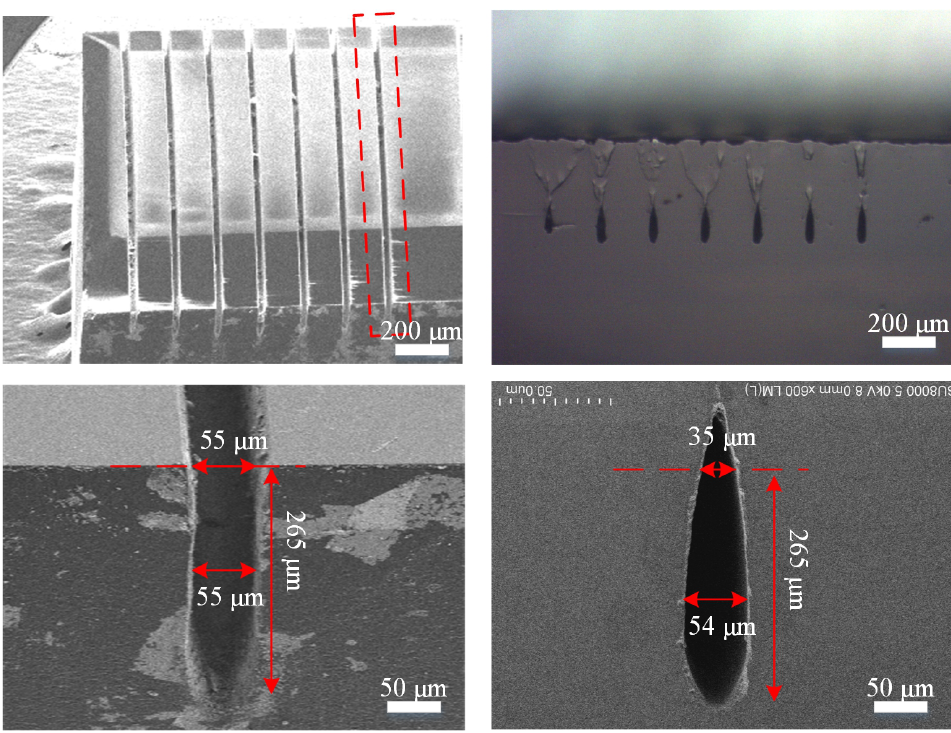
Figure 2. Cross-section SEM image of single crystal diamond (SCD) substrate ( a ) after laser treatment (45 ◦ ); ( b ) after epitaxial lateral diamond overgrowth; ( c ) enlarged view of trenches; ( d ) enlarged view of ( b